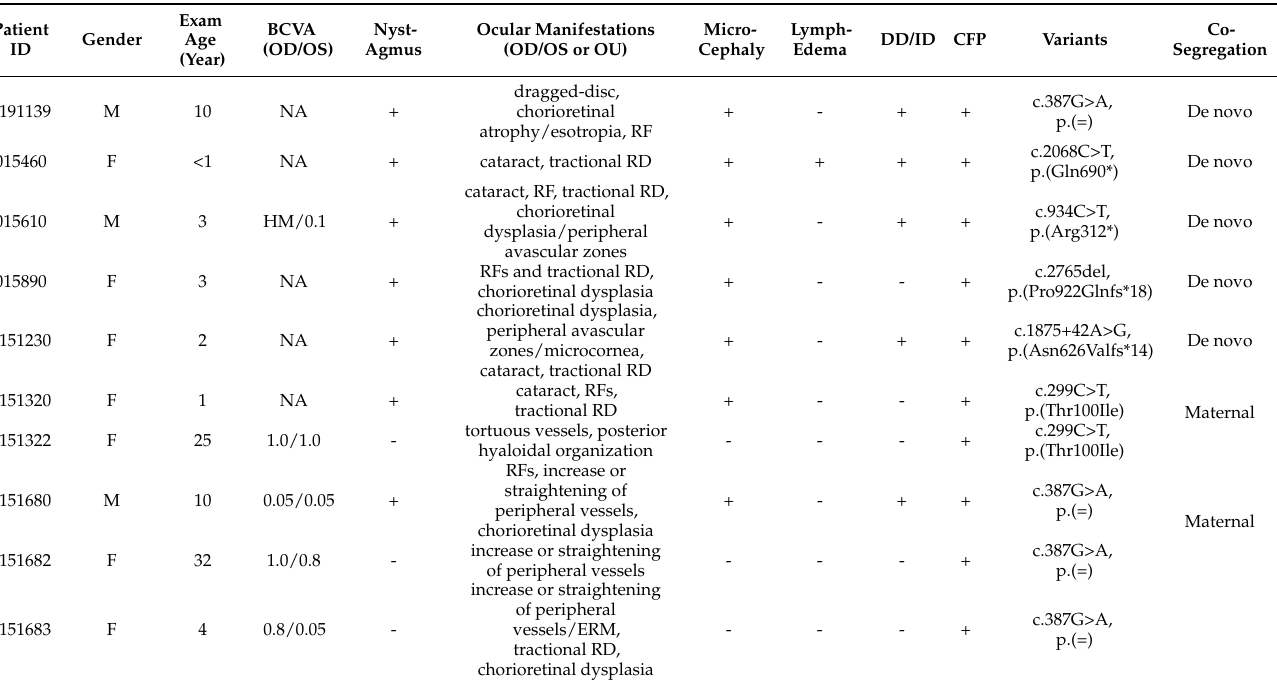
Table 3. Clinical data of individuals carrying pathogenic variants in KIF11